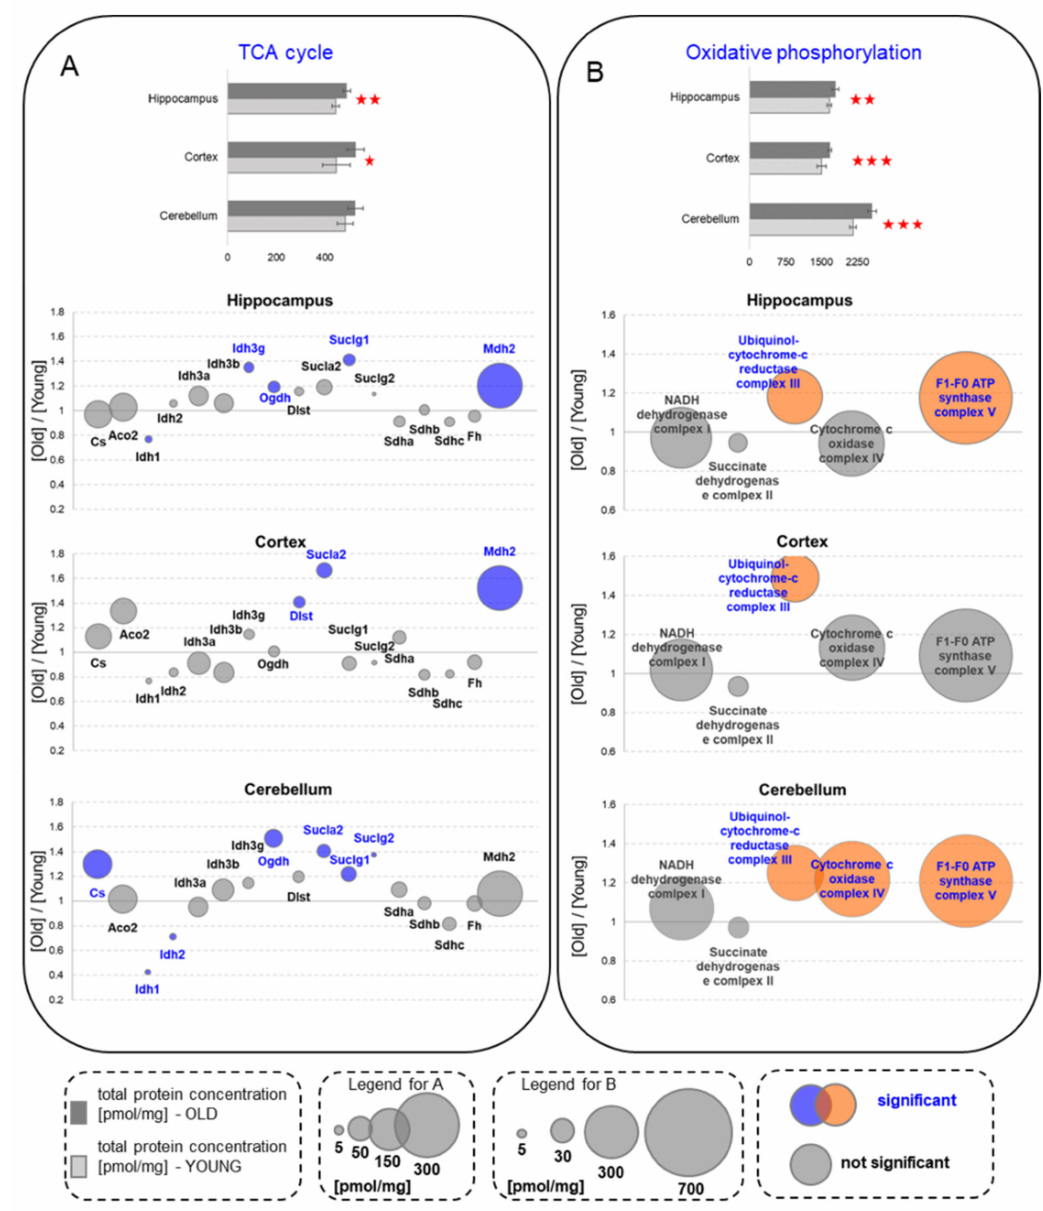
Figure 6. Changes in the energy metabolism processes upon aging—oxidative metabolism. ( A ) Krebs cycle (TCA). ( B ) Oxidative phosphorylation (the plot bubbles refer to the sum of all subunits in each complex). Column plots show total protein concentration summarizing each metabolic pathway for young and old animals in the hippocampus, cortex and cerebellum. The statistically significant changes between age groups are indicated (* p < 0.05; ** p < 0.01, *** p < 0.001). Bubble plots show ratios of protein concentrations in the old vs. young hippocampus, cortex and cerebellum. The size of the bubbles is proportional to an average protein concentration. Proteins with significantly changed concentrations are highlighted in blue in A and orange in the B panel. Abbreviations: YOUNG—1-month-old and OLD—22-month-old